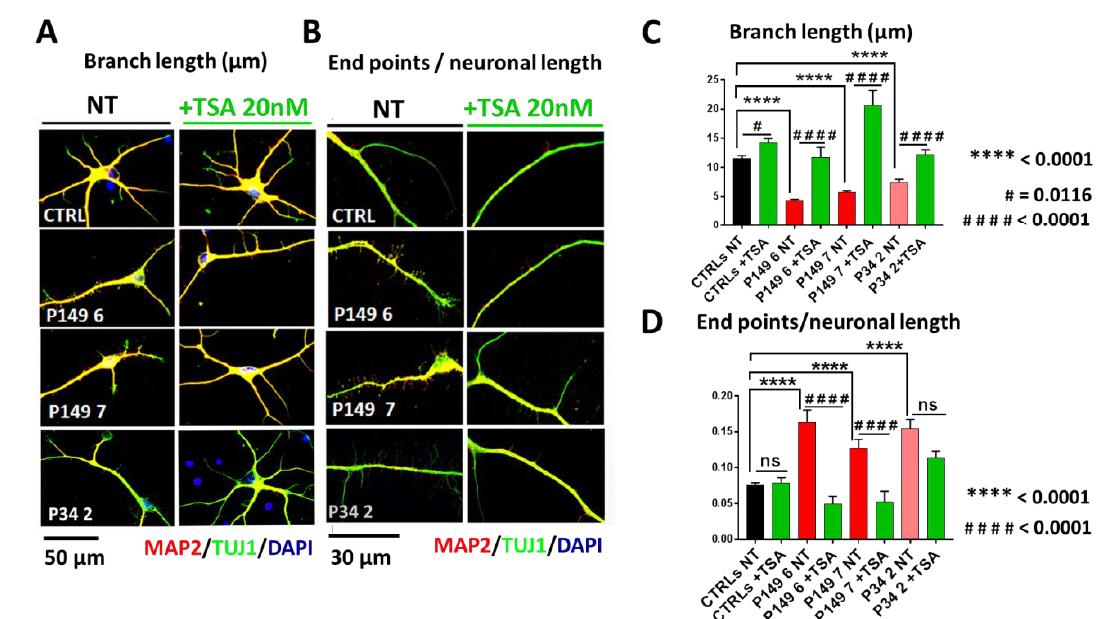
Figure 4. Aberrant branch length and end point number/neuronal length in CREBBP -mutated patients with respect to controls lines and partial rescue after TSA treatment. ( A – C ) Immunofluorescence of MAP2 (red), TUJ1 (green), and DAPI (blue) — scale bar 50 µm — shows decreased branch length in all patients lines with respect to controls, quantified as highly significant by Kruskal – Wallis test. Effect of genotype is represented by **** p < 0.0001. TSA treatment determines a significant correction of this morphological aberration. Effect of TSA treatment is represented by # p = 0.0116, #### p < 0.0001. ( B – D ) Increased number of end points/neuronal length in all patients lines with respect to controls lines is apparent at IF — scale bar 30 µm — and results highly significant at Kruskal – Wallis test. Effect of genotype: **** p < 0.0001. ( D ) The graphs also quantify the significant reduction in the end points/neuronal length ratio in both P149 lines and a trend to correction in P34 2 after TSA treatment. Effect of TSA treatment: ns = not significant, #### p < 0.0001.